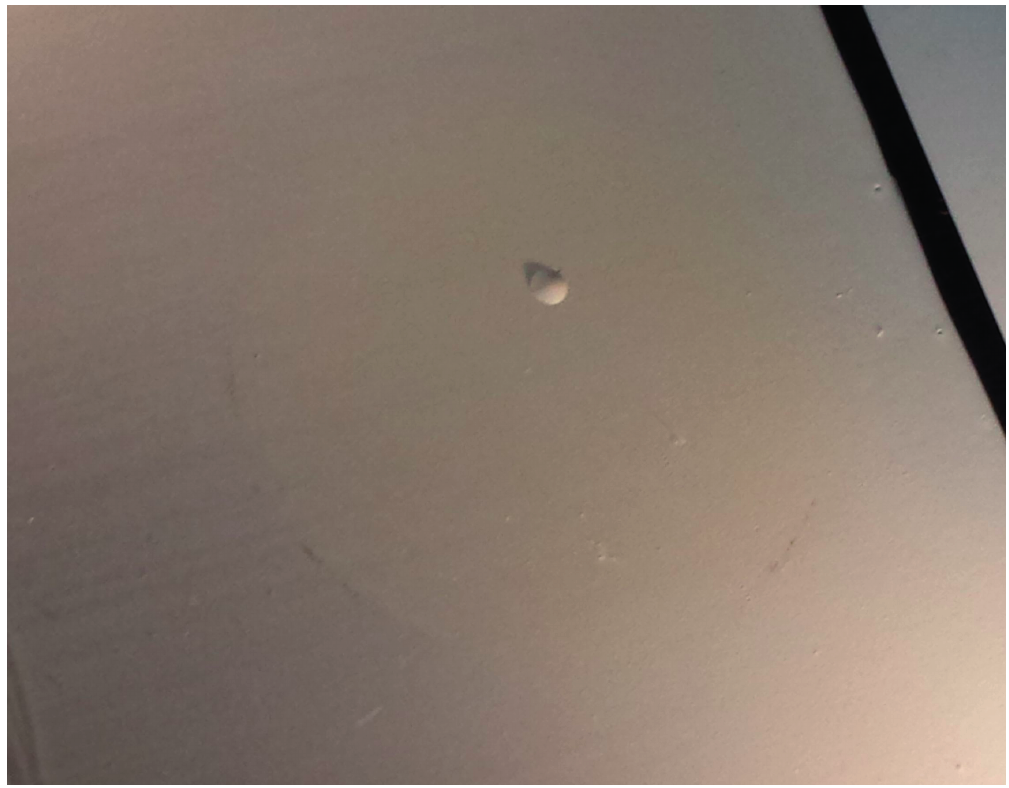
Figure 4. Blisters on sample coated with unfilled water-based epoxy resin after 7 days of immersion in aqueous NaCl